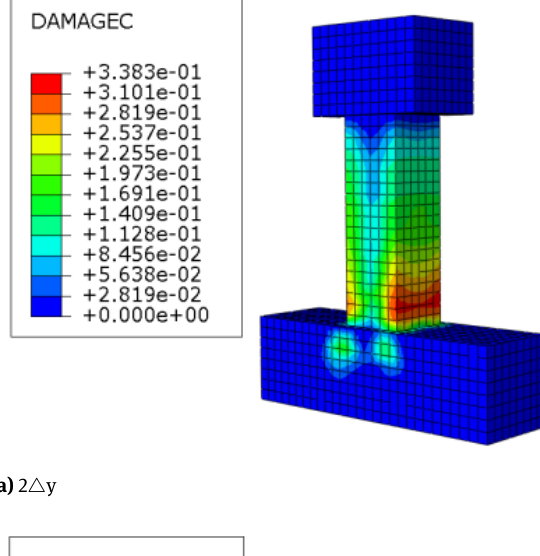
Figure 13: Nephograms of Compression Damage of C4